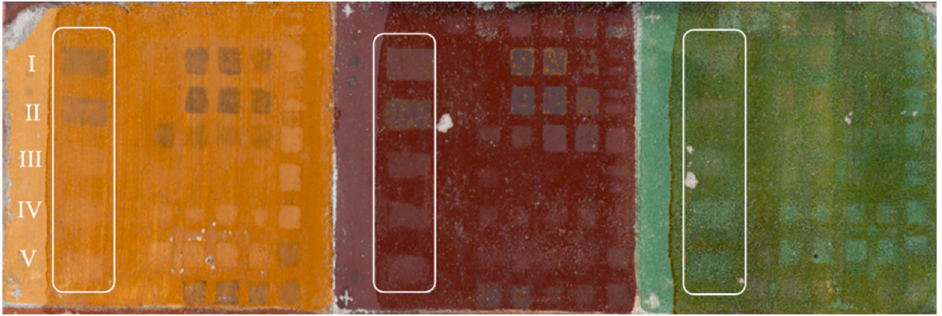
Figure 2. RGB image of the mock-up: white rectangles denote 1 × 2 cm 2 zones of I–V laser tests as reported in Table 2, and are referred to as time 2 (t 2 ). Other zones report the preliminary laser